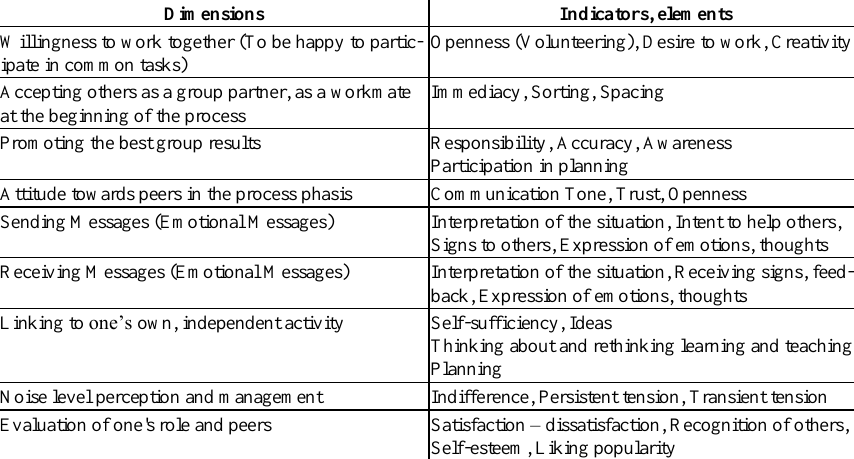
Table 1. Dimensions and indicators Dimensions Indicators,